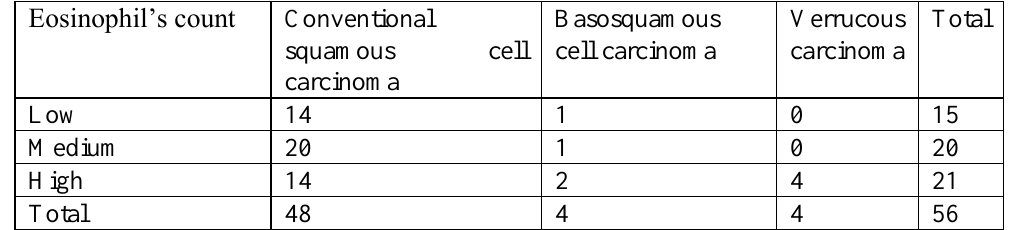
Table 1: Assessment of tissue eosinophilia in cutaneous squamous cell